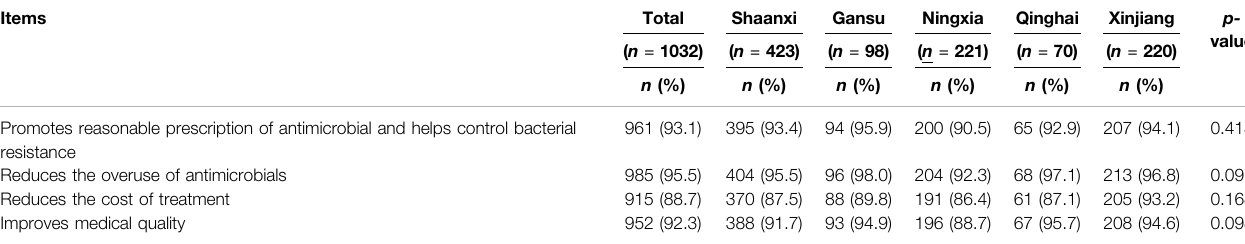
TABLE 2 | Pharmacist ’ s perception toward the importance of AMS (combined agree or strongly agree response). Items